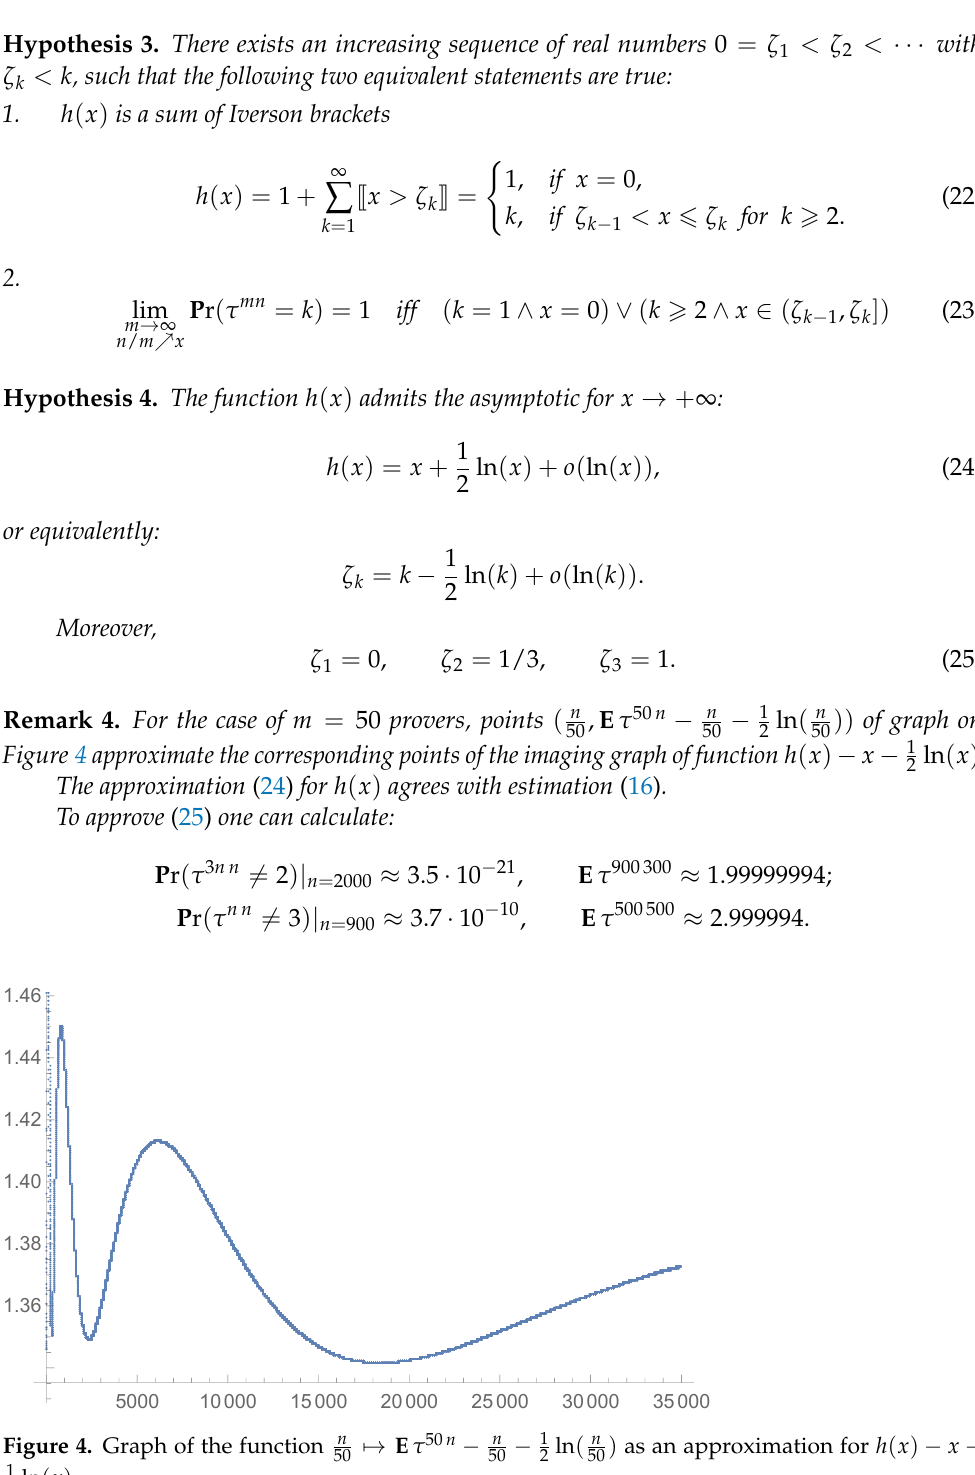
Figure 4. Graph of the function n 1 ln ( x ) 2